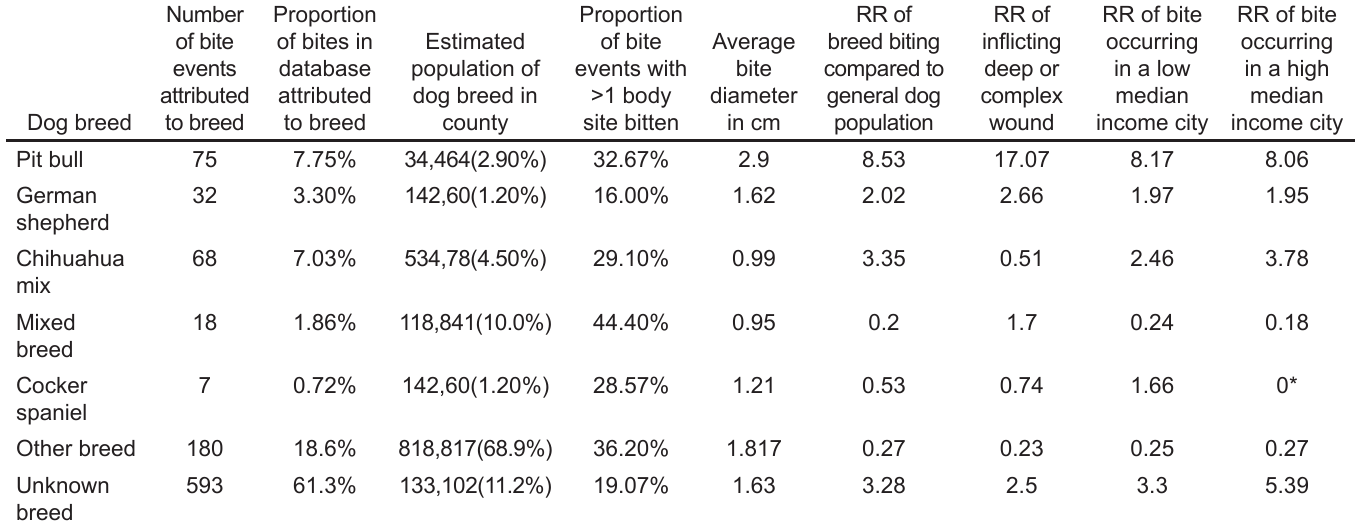
Table 5. Relative risk* of bite by dog breed using estimated dog population.